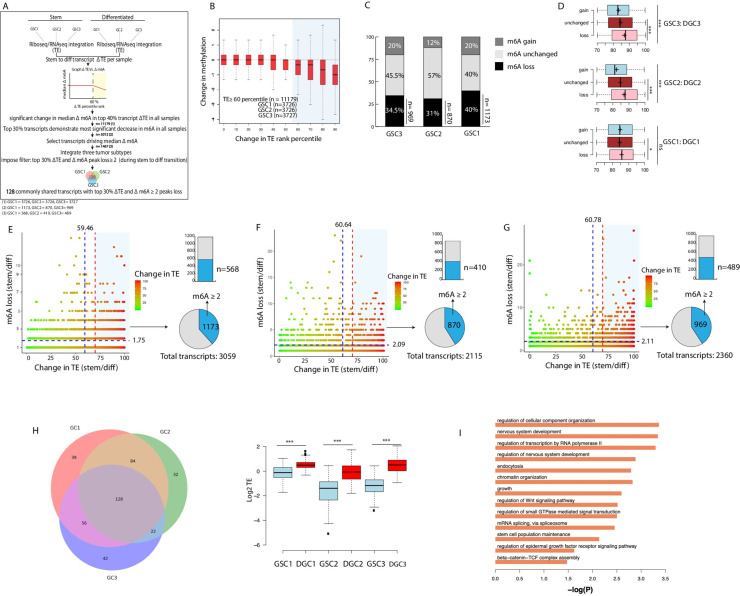
Transcripts with increased translation efficiency during GSC to DGC transition have a significant loss in m6A methylation.A) A schematic of the analytical approach with an emphasis on the filtering process from n = 11,179 transcripts to 128 common transcripts. B) Change in TE rank percentile plotted as function of methylation change. Highlight identifies regions with median m6A change ≠ 0, corresponds to GSC 1,2 and 3 (n = 11179) and to top 40% transcripts with the highest increase in TE following differentiation. Change in TE rank obtained by measuring degree of change in TE of individual transcripts between their respective GSC and DGC state and then ranking the transcripts accordingly (ranges from highest rank: greatest increase in TE with transition; to lowest rank: most decrease in TE). C) Percent composition of top 30% transcripts with most significant change in TE based on m6A status in individual samples (gain/unchanged/loss). D) Change in TE rank in transcripts grouped by m6A status (gain/unchanged/loss) (***p<0.001, Wilcoxon test). Crosses represent mean values. E) GSC1: Transcript m6A loss binning correlated with change in TE, vertical blue line indicates median change in TE rank, vertical red line demarcates the top 30% change in TE ranks, horizontal blue lines represent average m6A peak loss across all peaks. Pie chart shows top 30% transcripts as a fraction of all transcripts with m6A loss. Stacked graph emphasizes transcripts with ≥ 2 peaks loss from the top 30% ranked transcripts in terms of TE change during differentiation. F) GSC2: see E. G) GSC3: see E. H) Shows 128 common transcripts across all samples, extracted from transcripts with ≥ 2 peaks loss and change in TE rank ≥ 70th percentile. Boxplot showing log2 TE in individual samples in respective GSCs and DGCs pairing (***p<0.001, Wilcox test). I) Pathway enrichment of 128 common transcripts across subtypes.